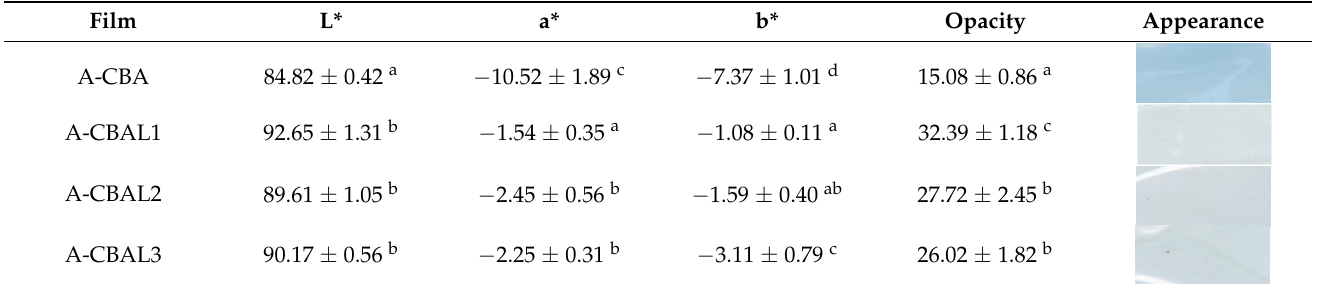
Table 2. The colors and opacity values of the films.